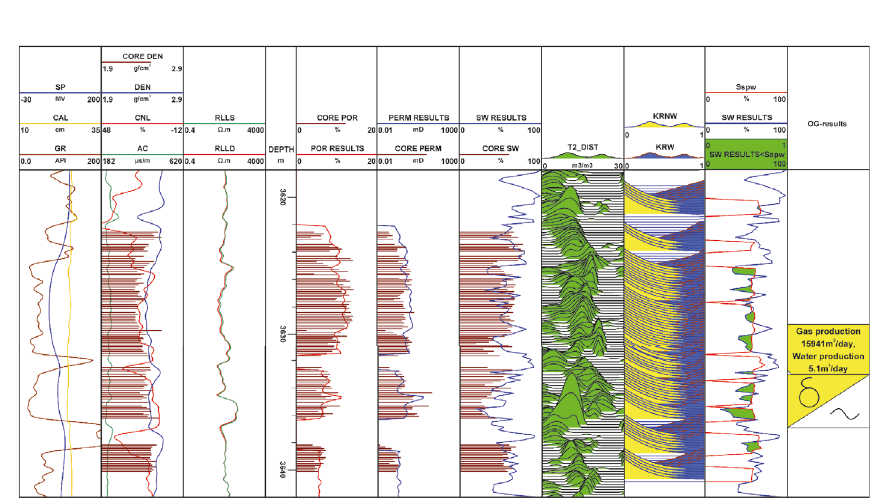
Figure 10: Comprehensive logging interpretation chart of Well